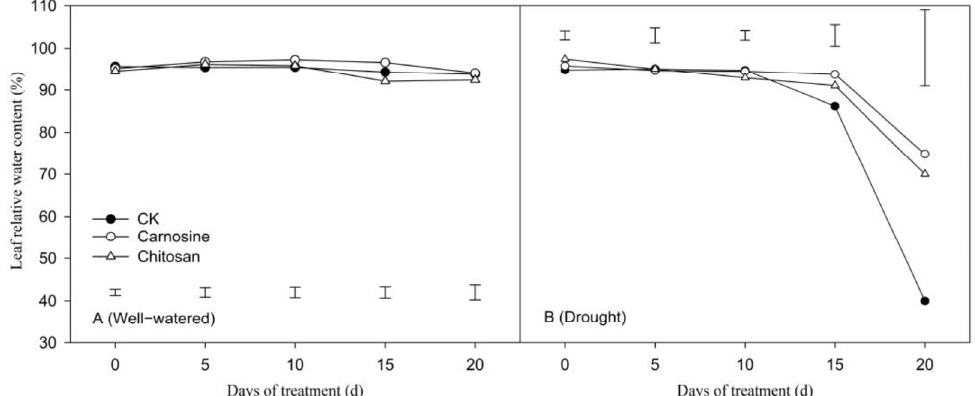
Figure 4. Effects of different concentrations of carnosine and chitosan on leaf relative water under drought stress in bermudagrass. ‘CK’ represents control plants sprayed with distilled water under both well-watered and drought stress. Vertical bars represent LSD values where a significant difference ( p < 0.05) was detected among different treatments at the same time point.